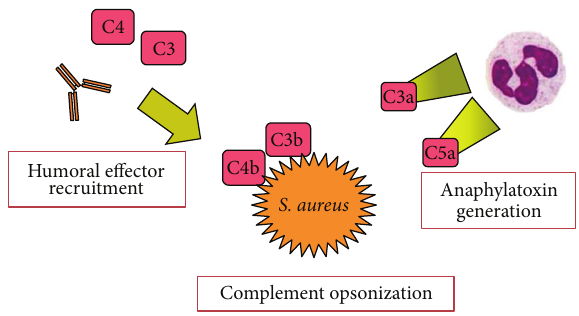
Figure 7: Summary of hyperglycemic effects on humoral immune responsesto S. aureus peritonitis.Hyperglycemia inhibitedantibody and complement effector recruitment to the site of infection. Hyperglycemia inhibited complement opsonization of S. aureus and complement anaphylatoxin